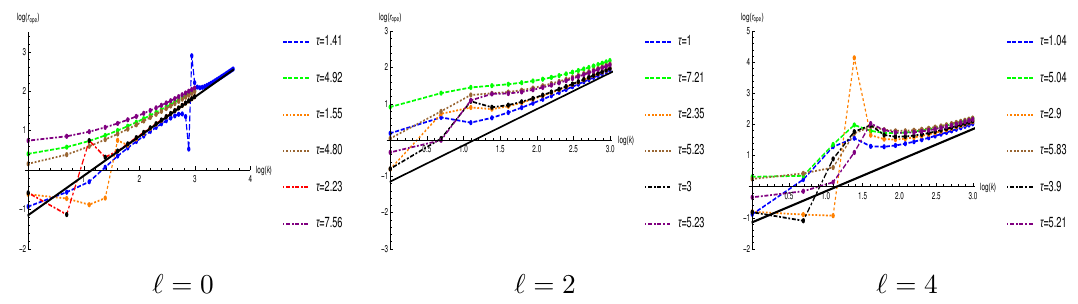
Figure 2 . Plots of log r OPE vs log k for various twists and spins. The solid black line is r OPE = k=(cid:25) . The dashed lines are for d = 3 ; (cid:1) (cid:30) = 0 : 518, the dotted lines are for d = 4 ; (cid:1) (cid:30) = 1 : 28 and the dot- dashed lines for d = 5 ; (cid:1) (cid:30) = 1 : 88. The OPE for the (cid:28) = 1 : 41 ; d = 3 exhibits an interesting feature which needed us to go to a higher number of points to see the asymptotic